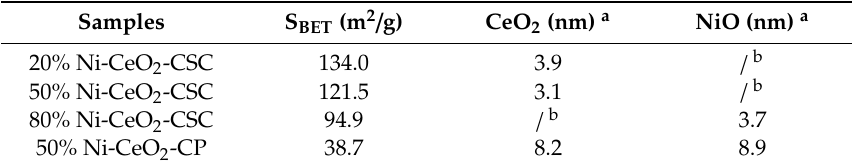
Table 1. Physicochemical properties of the fresh Ni-CeO 2.